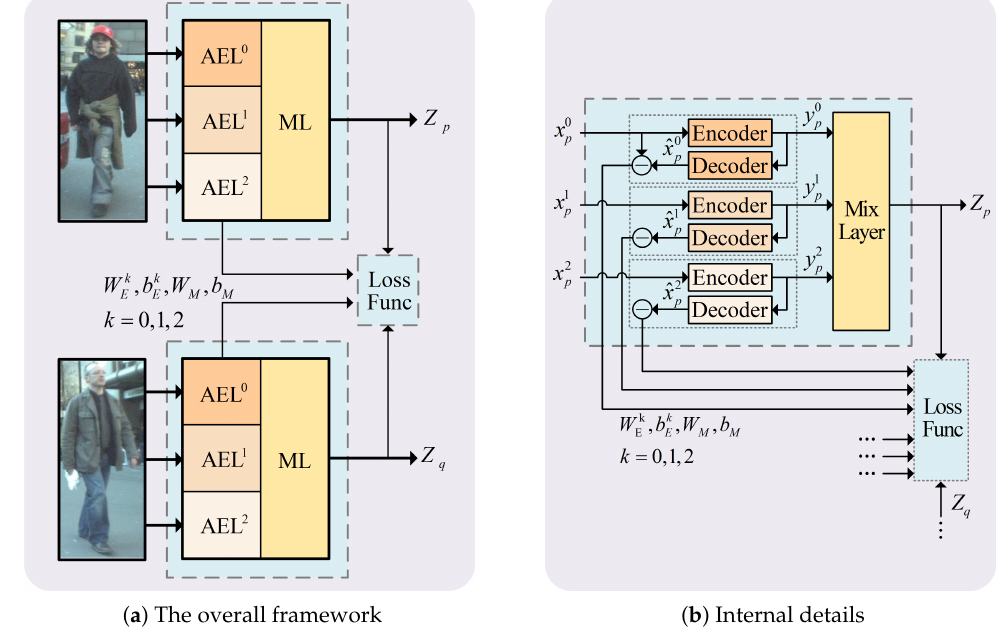
Figure 2. Structure of SNAC: ( a ) shows the overall structure of SNAC, including its symmetrical structure and parameter sharing. Here, AEL stands for auto-encoder layer, superscripts 0, 1, and 2 indicate image channel numbers, and ML stands for the code-mix layer. ( b ) is the internal anatomical diagram of the SNAC structure, showing its auto-encoder layer and code-mix